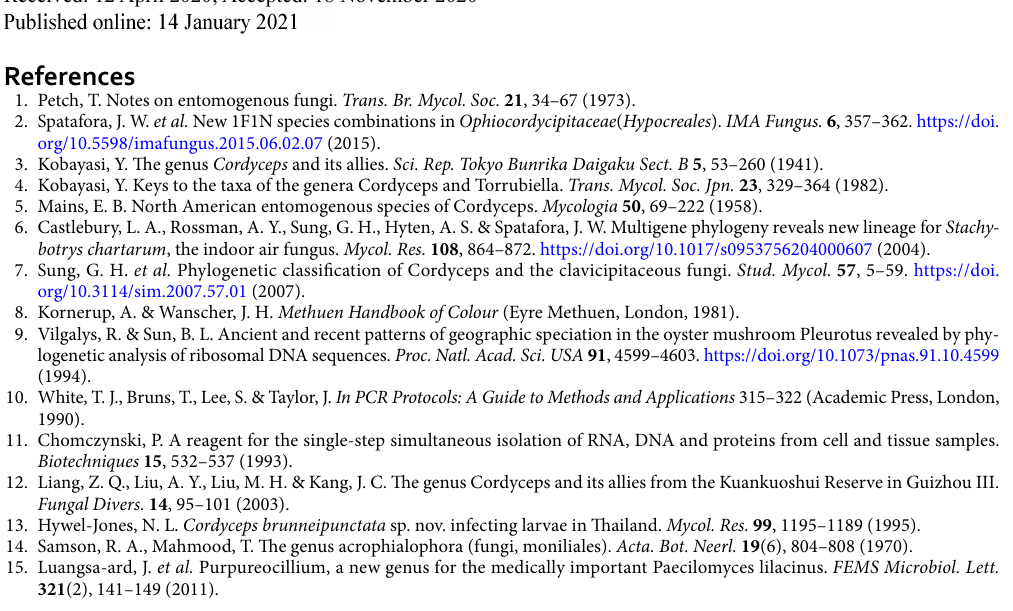
Table 4. Comparison between Ophiocordyceps langbianensis và Ophiocordyceps brunneipunctata. a Reference from Ophiocordyceps brunneipunctata (Hywel-Jones) G.H. Sung, J.M. Sung, Hywel-Jones & Spatafora.